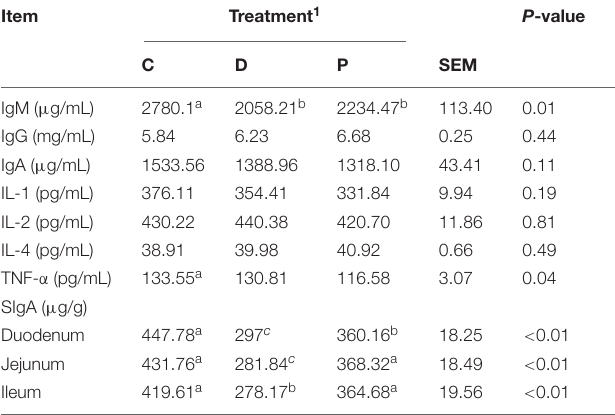
TABLE 1 | Effect of MSP supplementation on the serum immune function and the content of SIgA in neonatal calves intestinal mucosa of neonatal calves infected by E. coli